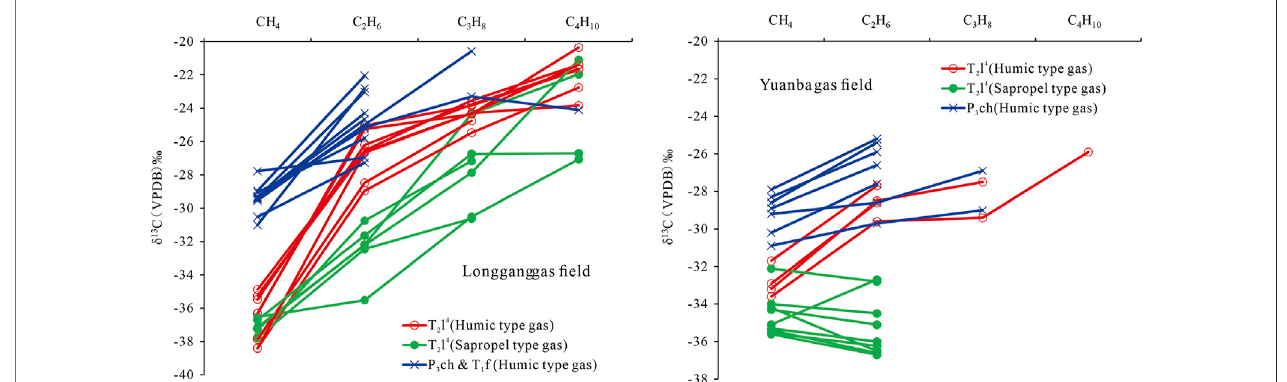
FIGURE 5 | Comparison of δ 13 C of natural gas between the T 2 l 4 reservoir and the P 3 ch-T 1 f reservoirs of the Sichuan Basin.